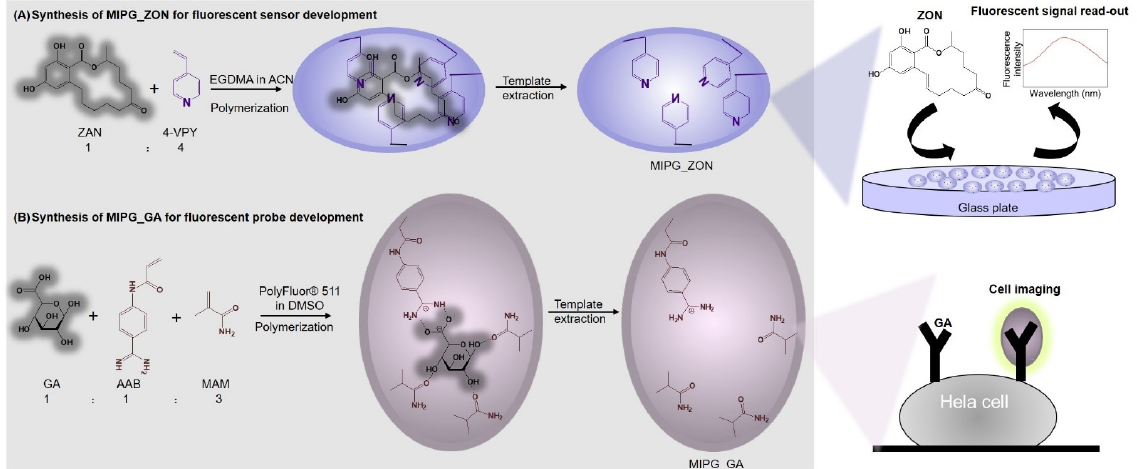
Scheme 1. Schematic illustration of molecular imprinting technology for two typical fluorescent sensors development. (A) The molecular imprinting process for the synthesis of MIPG_ZON, which can be pasted on the glass substrate in order to work as a sensor for ZON detection by reading out the fluorescence signal of ZON. (B) The molecular imprinting process for the synthesis of fluoresce-incorporated MIPG_GA as a fluorescent probe which can be directly used for cancer cell imaging.